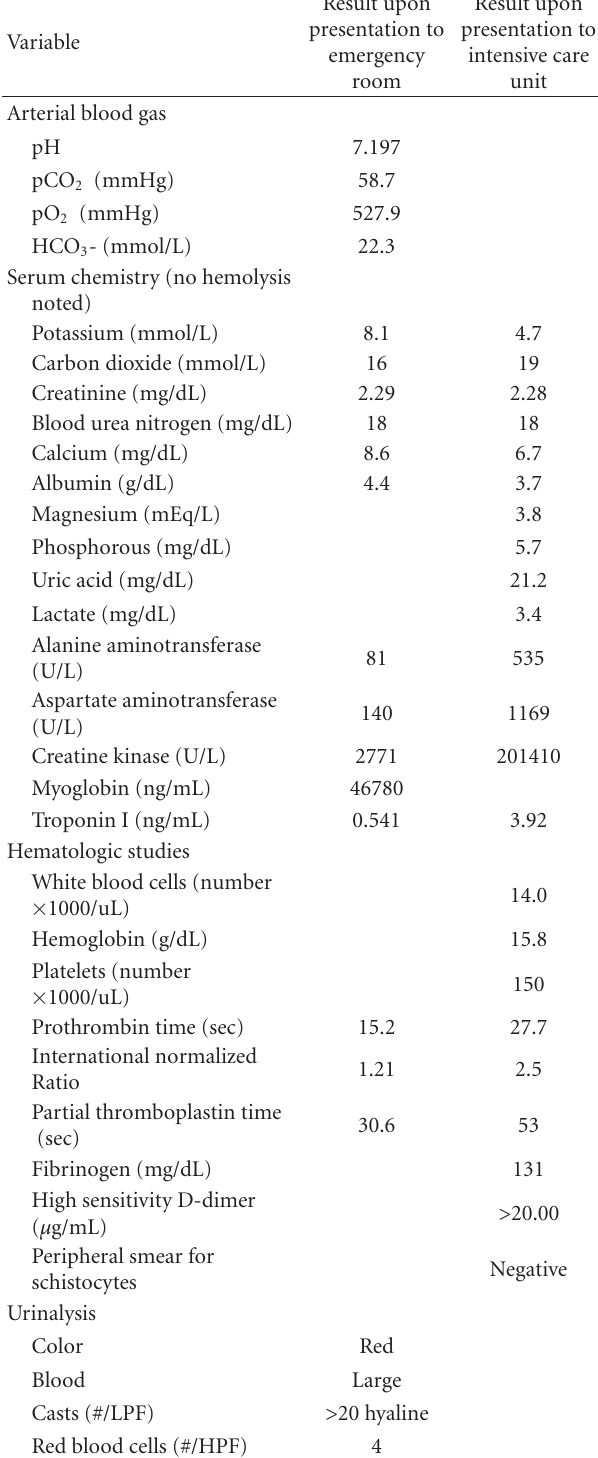
Table 1: Laboratory